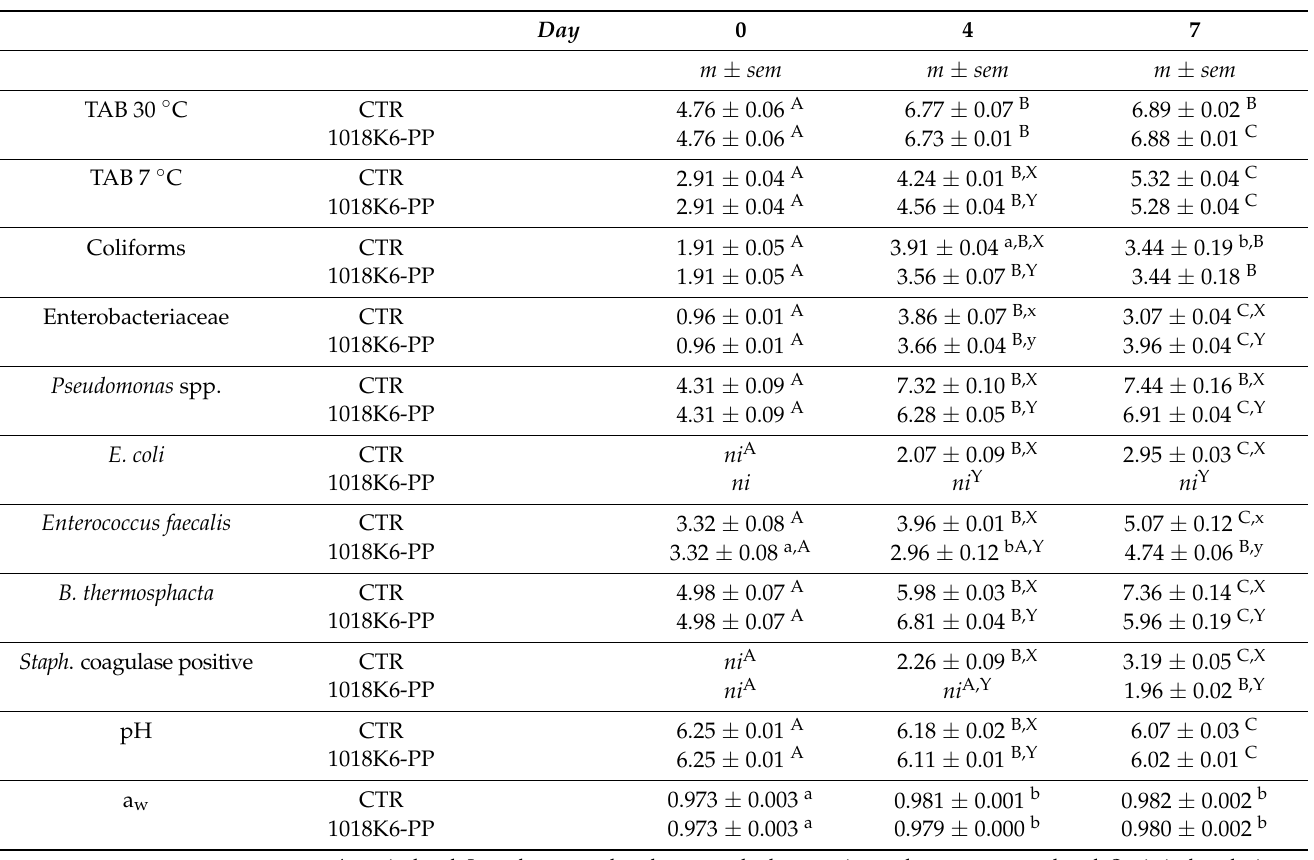
Table 1. Evaluation of microbiological counts [Log (CFU/g)] in salmon fillets packaged in active PP films functionalized with 1018K6 by storage